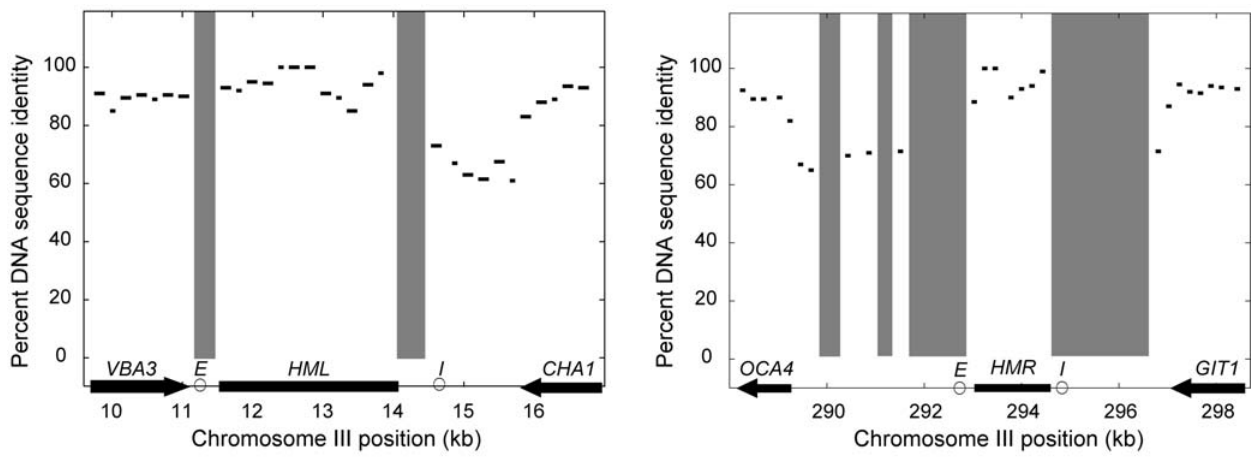
Figure 2. Lack of conservation in HML and HMR flanking intergenic regions. The results from the BLAST searches with S. cerevisiae HML and HMR and surrounding sequence against corresponding syntenic S. paradoxus contigs are shown with percent identity plotted for 200-bp windows. Genes are annotated on the x-axis. Segments without significant BLAST matches are shaded.